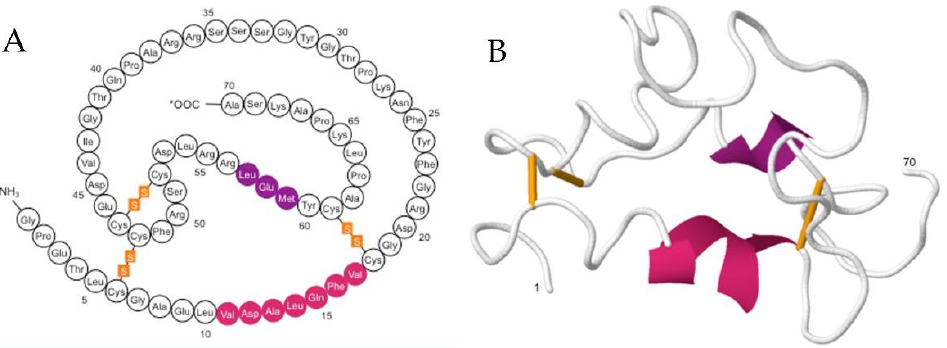
Figure 1. Structure of human Insulin-like growth factor-1 (IGF-1). ( A ) Primary structure showing disulphide bridge between amino acids 6 and 48, 18 and 61 and 47 and 52.; ( B ) 3D structure of IGF-1 showing folding of the polypeptide chain and secondary structural elements as ribbons (PDB ID: 1BQT).